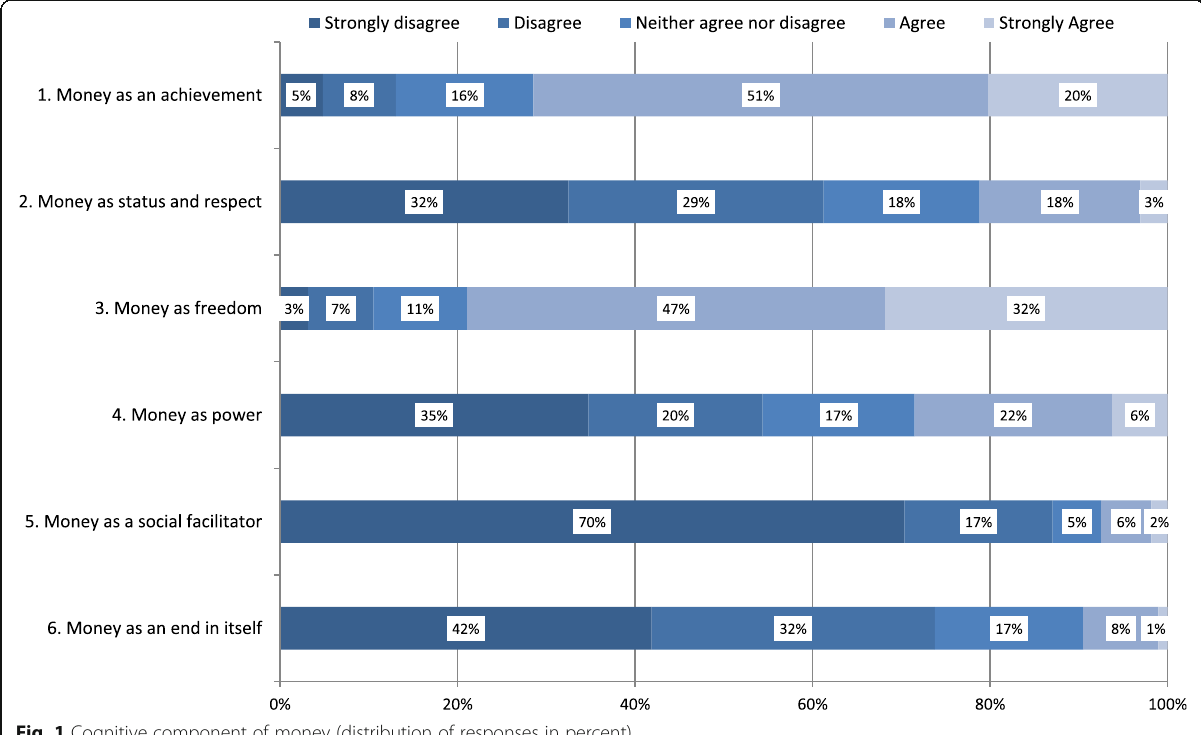
Fig. 1 Cognitive component of money (distribution of responses in